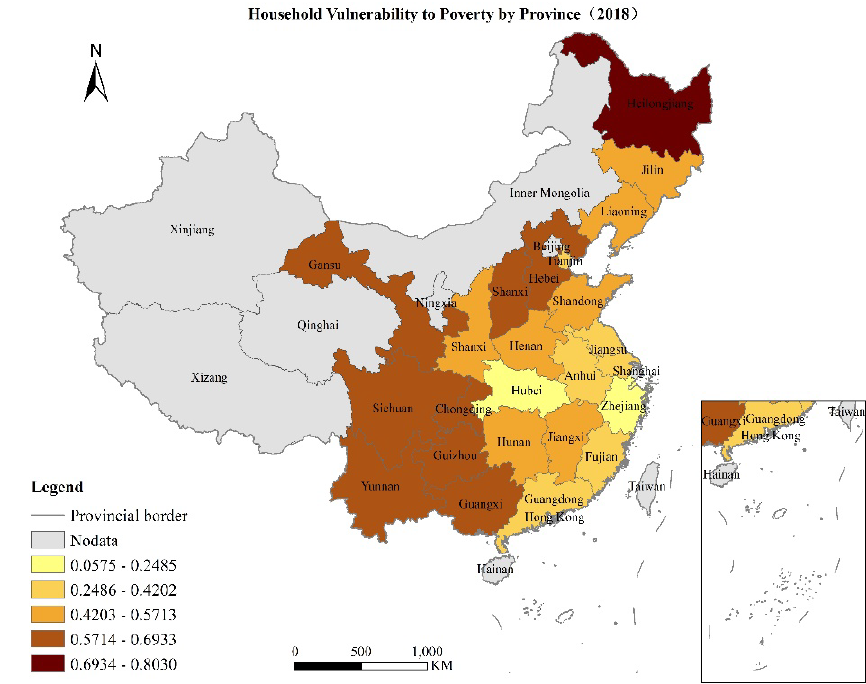
Figure 2. Household poverty vulnerability by province (2018).